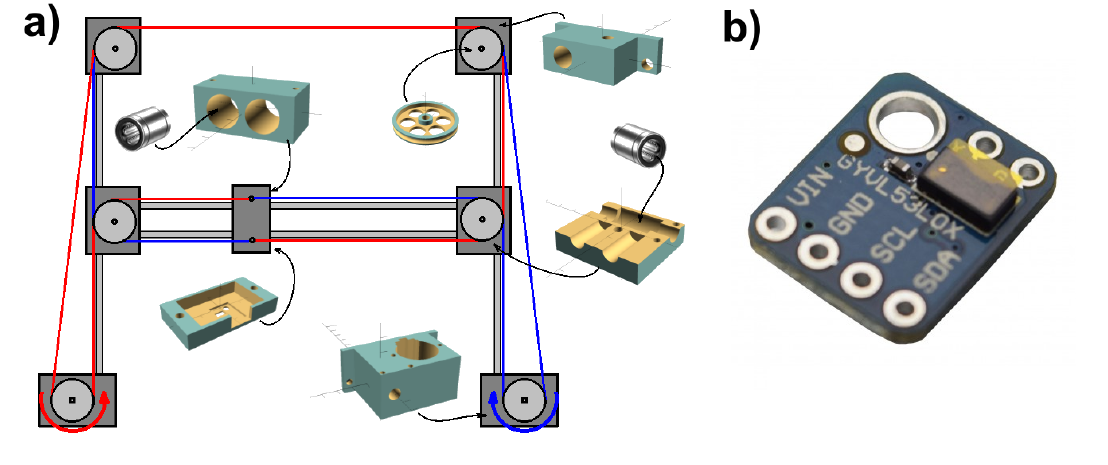
Figure 1. ( a ) Mechanical system general scheme. ( b ) Distance sensor